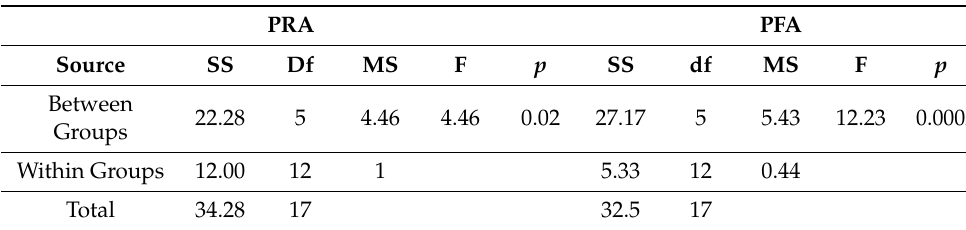
Table 8. ANOVA for efficacy of ANE on pod number when applied via pot foliar application (PFA) and pot root application (PRA).